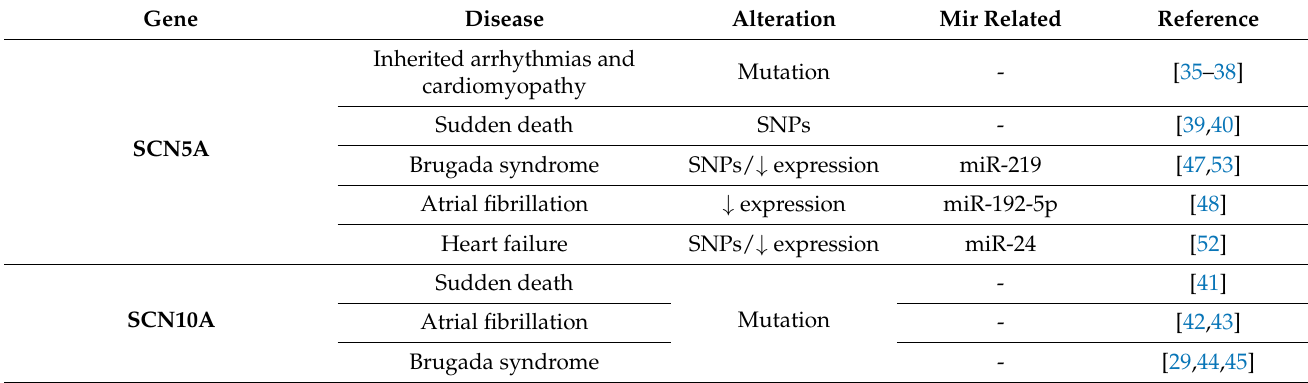
Table 2. List of genes involved in the cardiac action potential, their link to cardiovascular physiopathological conditions and their functional alterations in relation to distinct microRNAs signatures observed